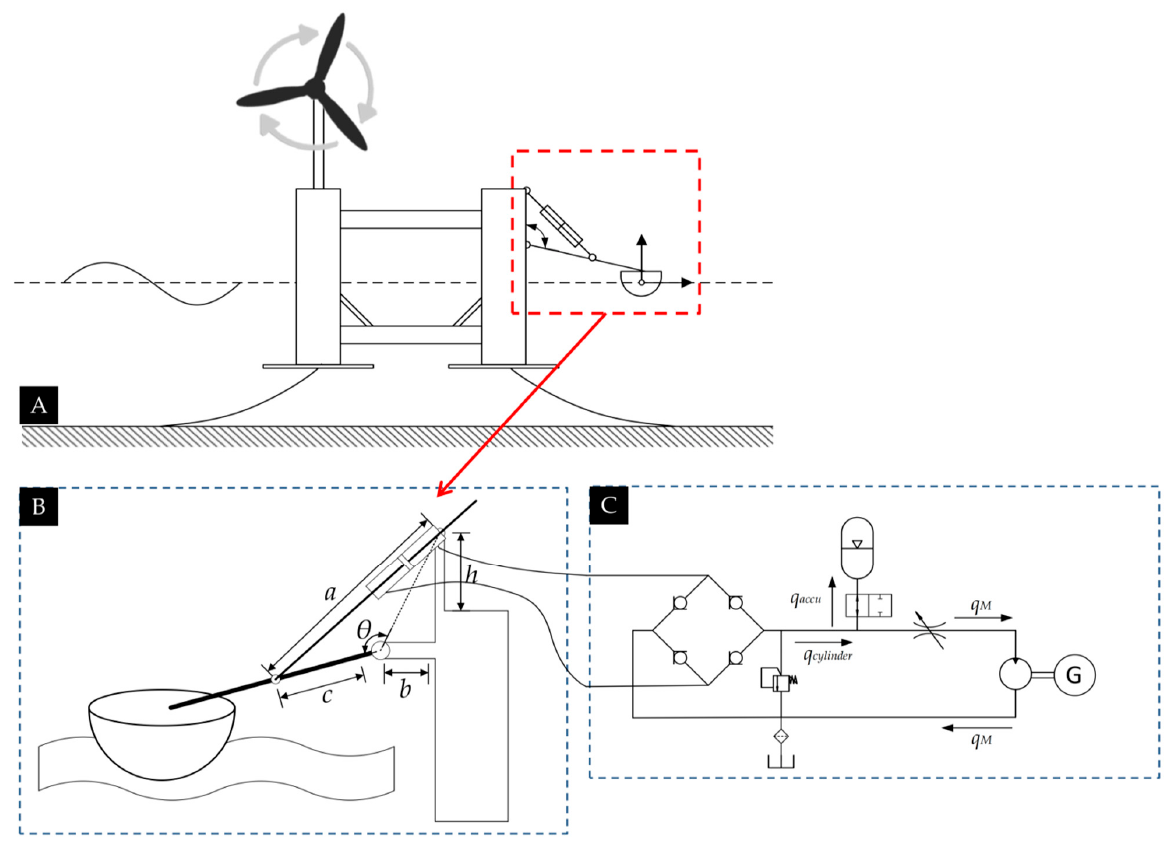
Figure 2. The detailed schematic diagram of the hybrid system. ( A ) Simple layout, ( B ) enlarged image of the interconnection between buoy, rocker arm, hydraulic actuator, and the floating platform, ( C ) principle schematic diagram of the hydraulic PTO system.